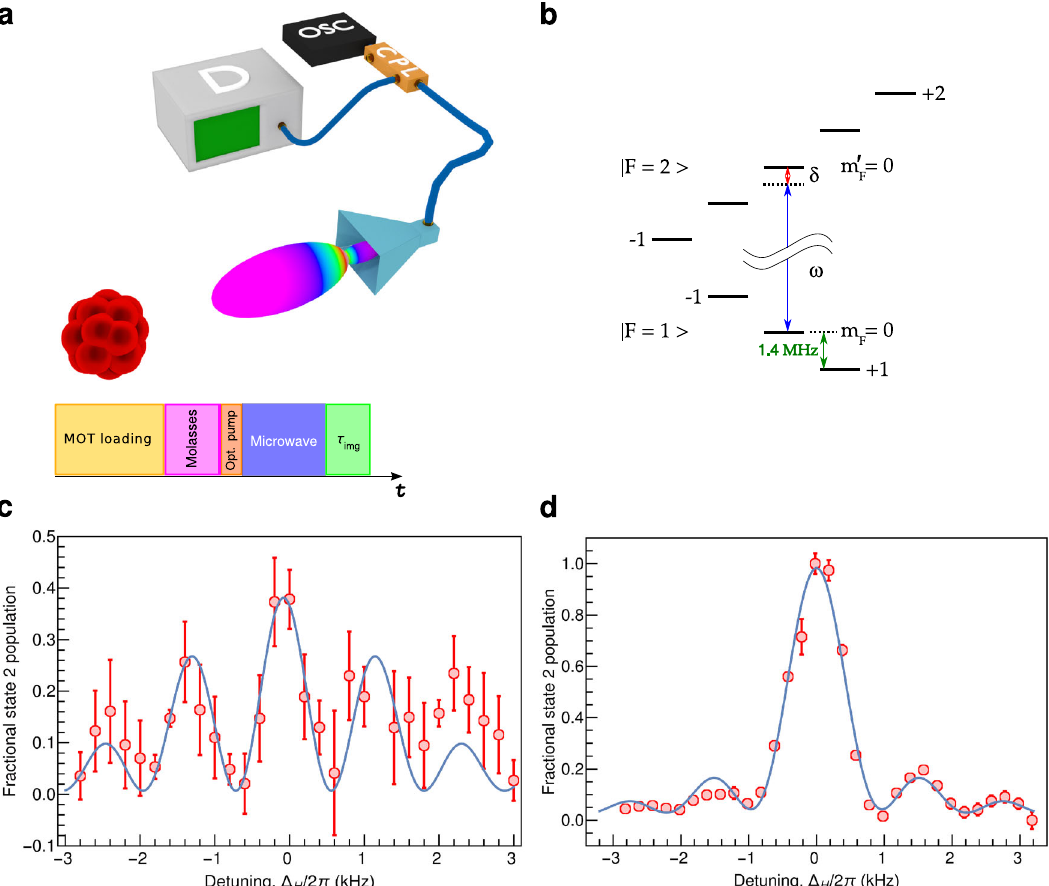
Fig. 1 Key elements of the experimental setup, timing sequence, level scheme, and level occupation probability. a Schematic of the experimental setup and generic timing sequence used in the measurements. The microwave generator (OSC) drives the horn antenna, used to excite and sense the atoms as represented here, through a bidirectional coupler (CPL). The atoms are detected via a modi fi cation of the antenna ’ s radiation impedance caused by their presence. This modi fi cation is observed in the re fl ected microwave power picked-up at the CPL reverse coupled port and measured with a detector (D), here a spectrum analyzer in zero span mode. The step “ Microwave ” in the sequence corresponds to driving and/or detection of the atomic populations. b Relevant energy levels of the hyper fi ne ground states of 87 Rb atoms under a quantization fi eld of 2 Gauss. The microwave at a frequency ω couples to the clock transition with an adjustable detuning. c Fractional state 2 population as a function of the horn detuning observed via the re fl ected wave power. d Spectrum of the fractional state 2 population as measured by absorption imaging. The blue solid lines are fi ts to the spectra using the two-level atom excited state population equation (see Supplementary Note 2). The error bars correspond to the standard deviation of repeated